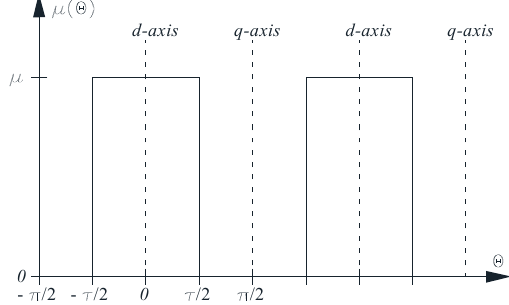
Figure 5. Equivalent unsaturated permeability along the air-gap circumference (according to [32]).